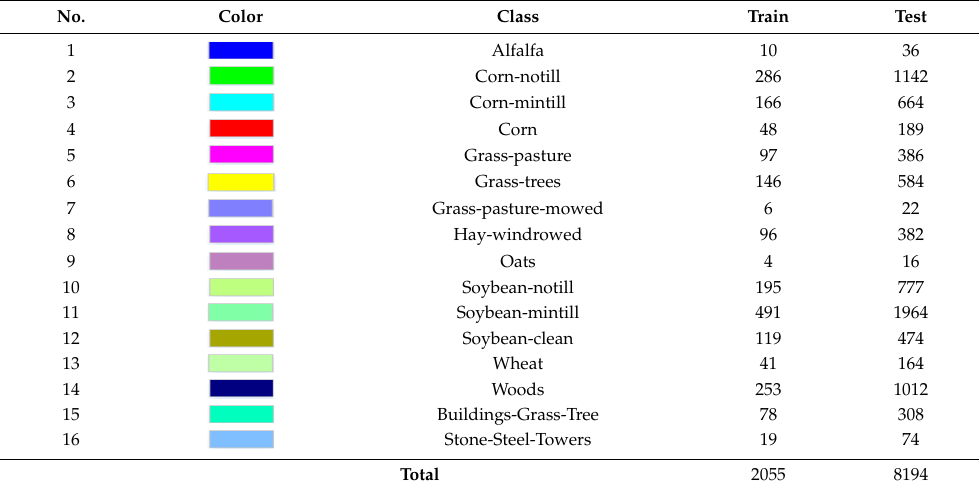
Table 2. The information on IP dataset, including number of training and test samples.